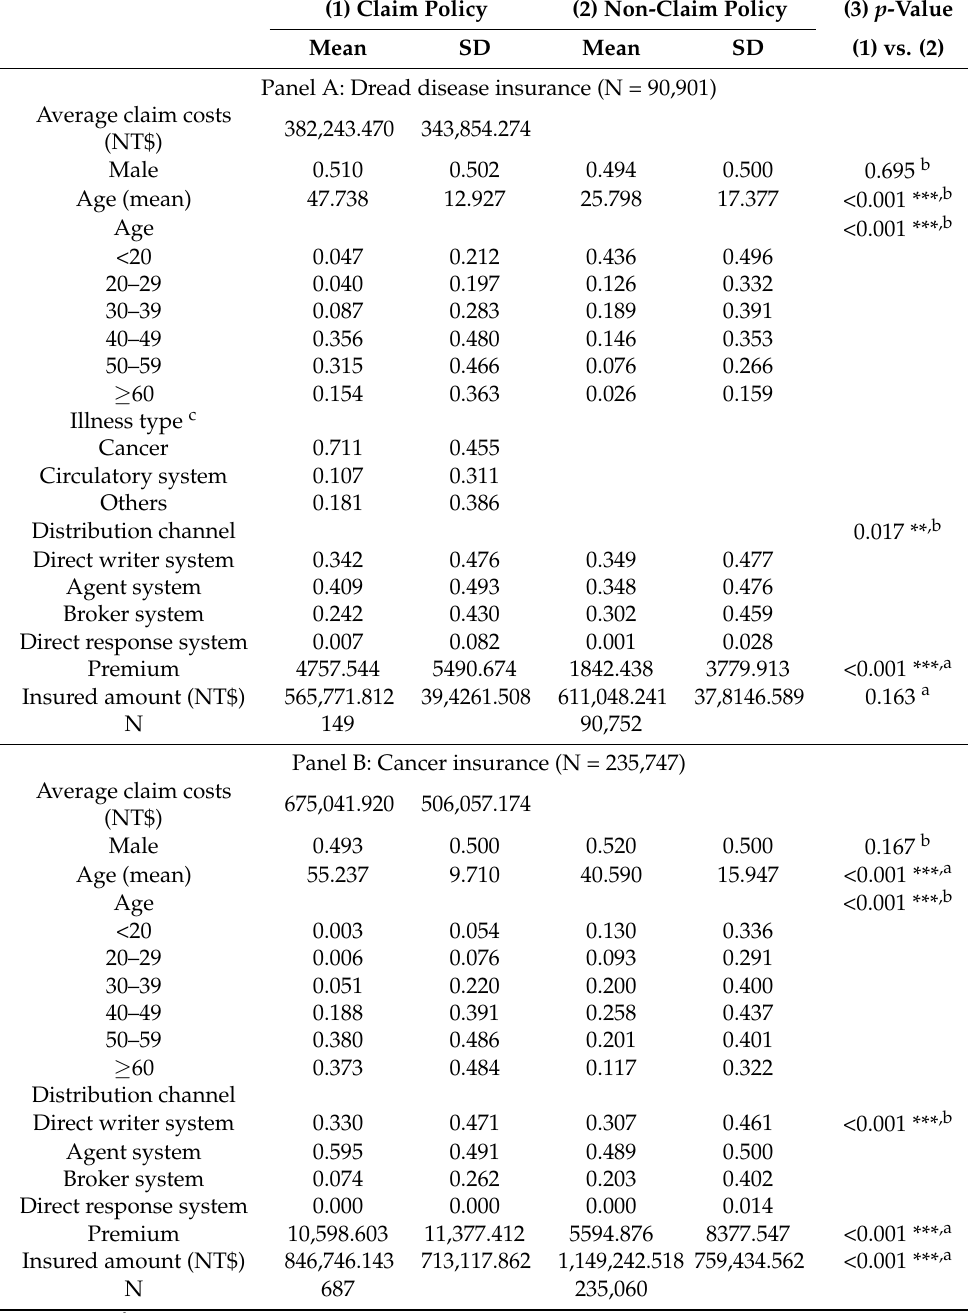
Table 2. Descriptive statistics of claim vs. non-claim policy